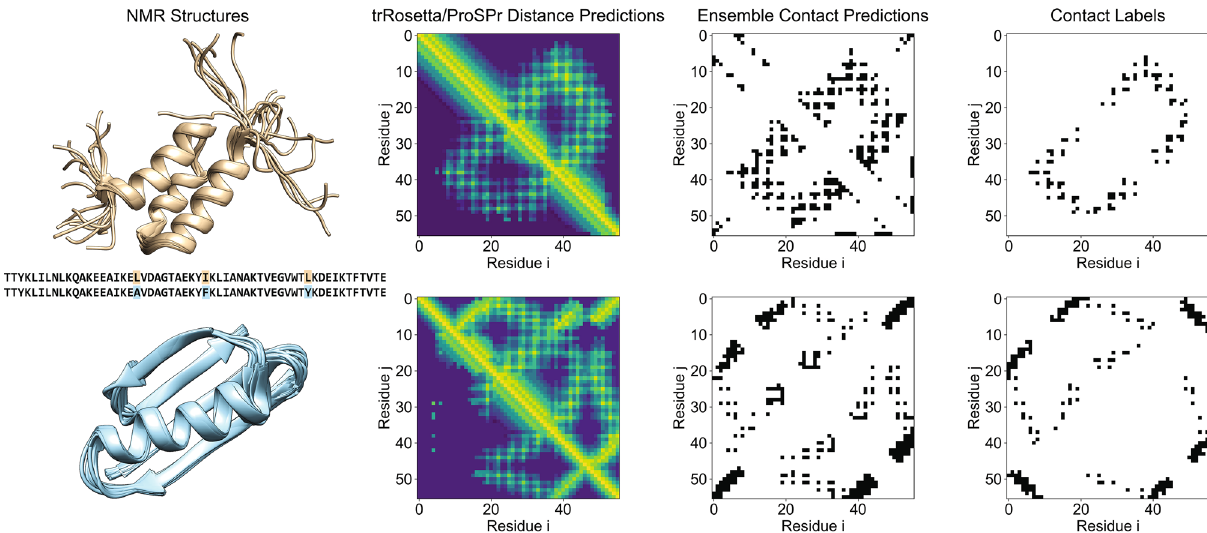
Figure 4. PDB 2KDL (first row) and 2KDM (second row) case example. The first column depicts the overlaid NMR structures reported in the PDB and the sequence, highlighting mutation points. The second column shows the distance predictions made by trRosetta in the bottom left half of the plot contrasted with ProSPr predictions in the top right diagonal. The third column shows the ensembled trRosetta and ProSPr contact predictions. The final column depicts the contact labels derived from the NMR